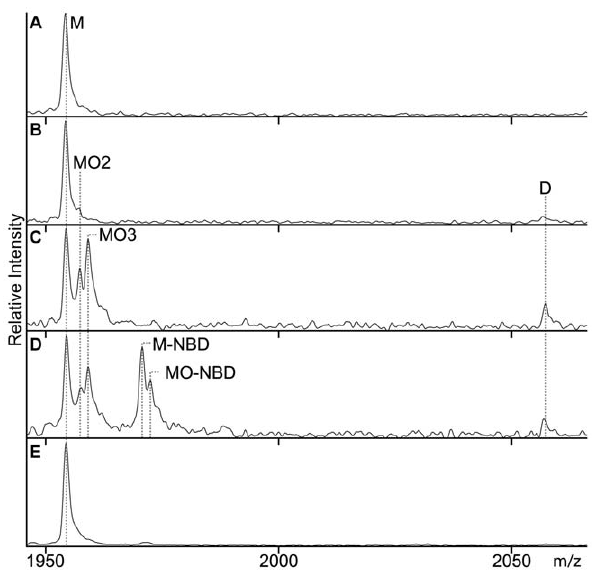
Figure 8. Monitoring of (apo)flavodoxin under H 2 O 2 -induced oxidative stress by LC-MS. For clarity, the zoomed in LC-MS regions that display the + 10 charge state of monomer and the + 19 charge state of dimer are shown (i.e., m/z range of 1940 to 2070); however, analysis is done on the whole m/z range. (A) Apoflavodoxin. (B) Apoflavodoxin incubated for 30 min with 10 mM H 2 O 2 . (C) Apoflavodoxin incubated for 30 min with 100 mM H 2 O 2 . (D) Apoflavodoxin incubated for 30 min with 200 m M NBD-Cl and 100 mM H 2 O 2 . (E) Flavodoxin incubated for 30 min with 190 m M NBD-Cl and 100 mM H 2 O 2 . Protein concentration is 5 m M and incubations were done at room temperature. M represents apoflavodoxin monomer with non-oxidised thiol; MO, MO2 and MO3 are the sulfenic, sulfinic and sulfonic acid states of apoflavodoxin, respectively. M-NBD is monomer protein with the thiol adduct of NBD- Cl, MO-NBD is monomer protein with the sulfenic acid adduct of NBD- Cl, and D represents disulfide-linked apoflavodoxin dimer.